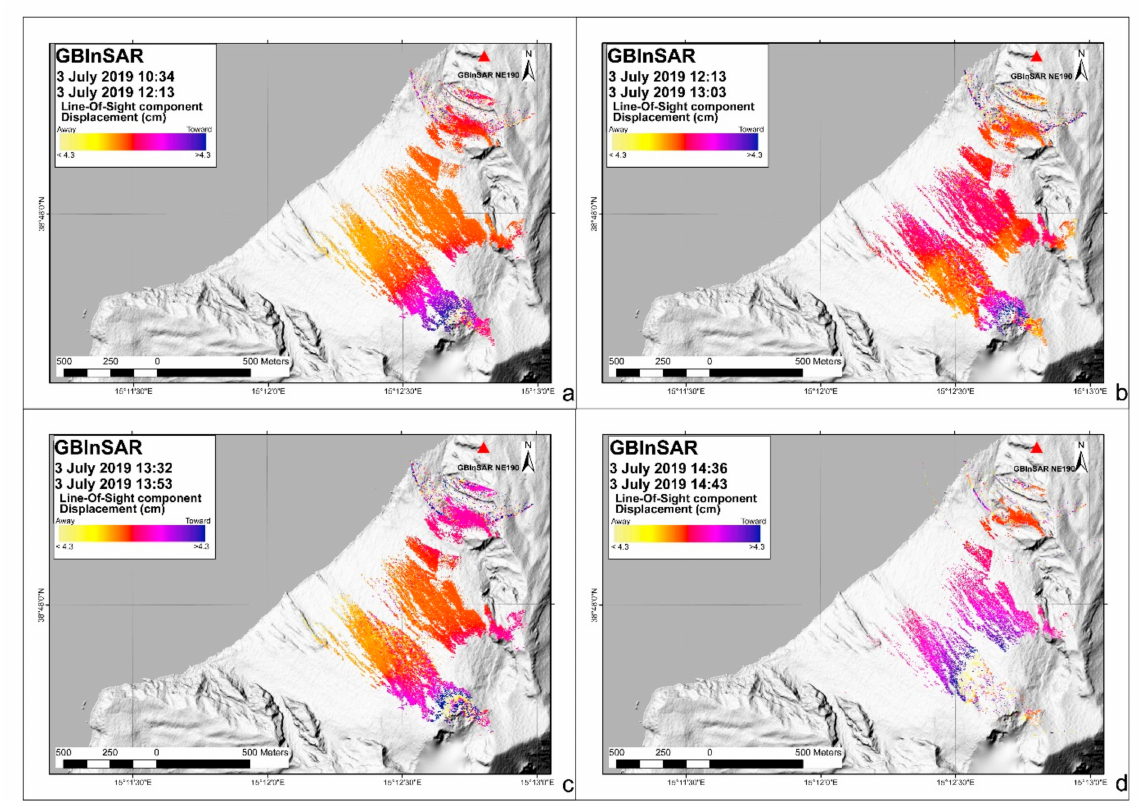
Figure 19. Ground deformation associated with the 3 July 2019 paroxysmal explosion. The interferogram, generated with GB-SAR NE190 system, revealed a progressive increase in the displacement rate, consistent with inflation of the crater terrace. ( a ) 3 July 2019 10:34-12:13 interferogram; ( b ) 3 July 2019 12:13-13:03 interferogram; ( c ) 3 July 2019 13:32-13:53 interferogram; ( d ) 3 July 2019 14:36-14:43